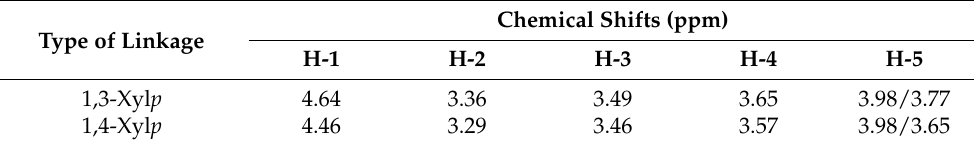
Table 2. Assignment of 1 H NMR spectrum of Yanang gum.